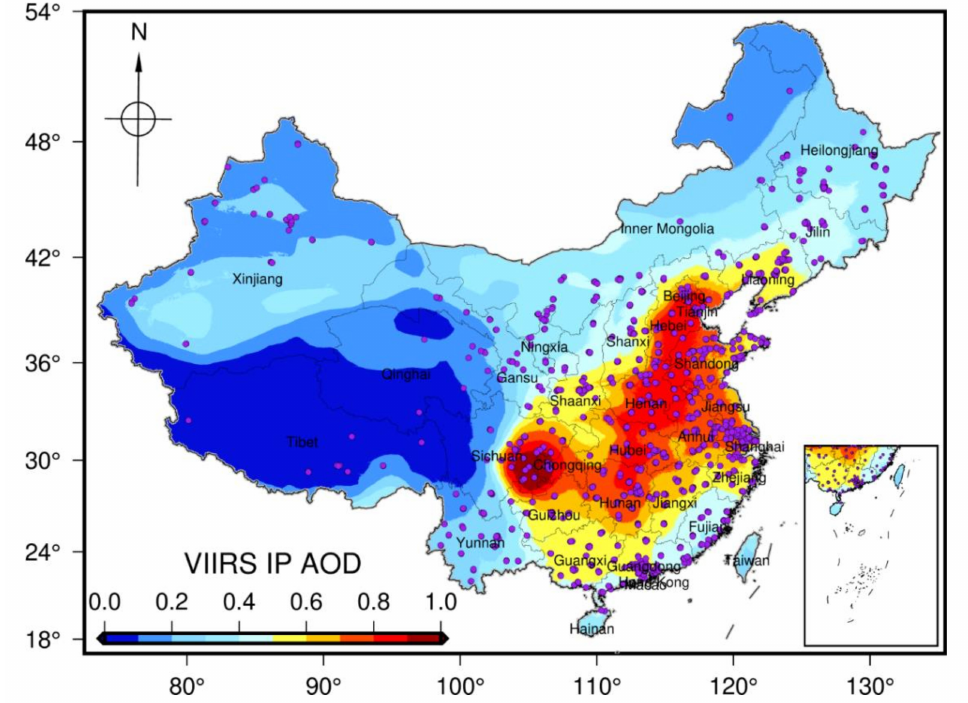
Figure 1. Spatial distributions of the PM 2.5 monitoring stations and annual mean VIIRS IP AOD